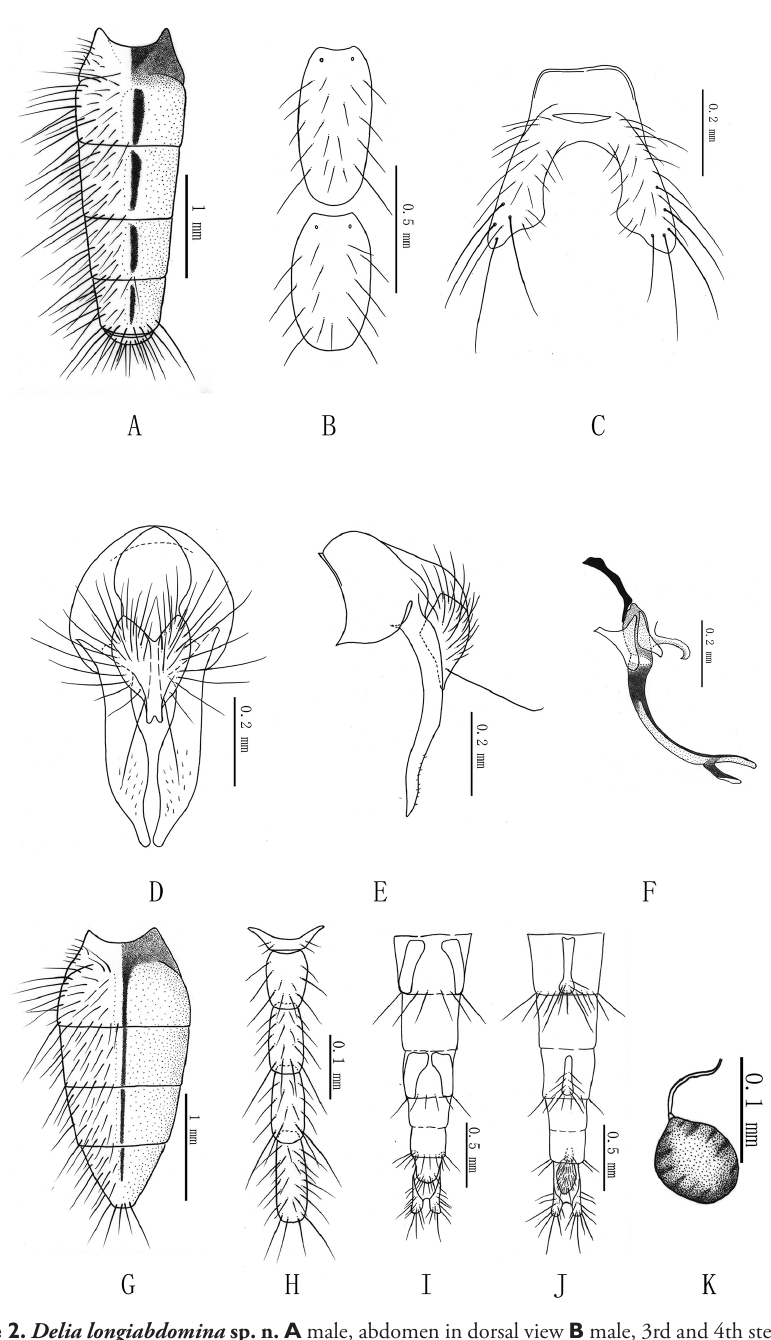
Figure 2. Delia longiabdomina sp. n. A male, abdomen in dorsal view B male, 3rd and 4th sternites in ventral view C male, 5th sternite in ventral view D male, terminalia in posterior view E male, terminalia in profile F male, aedeagus in profile G female, abdomen in dorsal view H female, sternites 1 to 5 I female, ovipositor in dorsal view J female, ovipositor in ventral view K female,